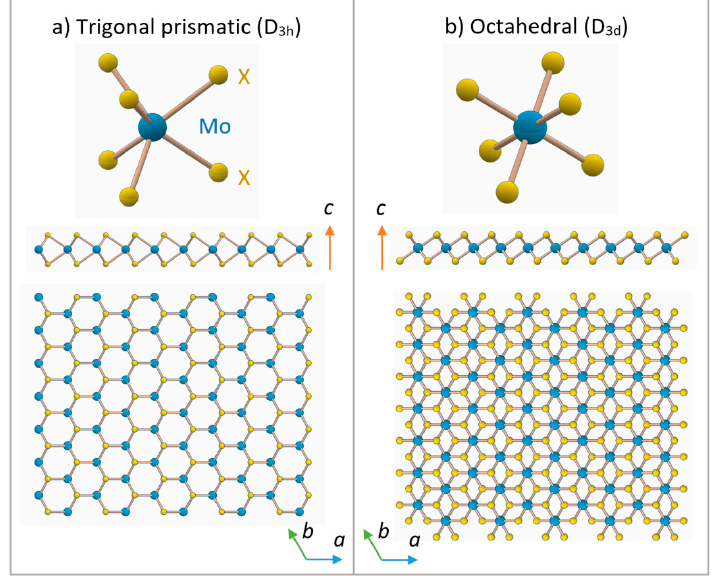
Figure 3. Trigonal prismatic ( a ); and octahedral ( b ) metal coordination, with respective c-axis and side sections, for Mo X 2 materials. Mo atoms are in blue, chalcogenides (X) atoms in yellow. ( a ) Represents a monolayer with 1H crystal structure, while ( b ) a monolayer with 1T crystal structure. Atomic radii are not in scale.